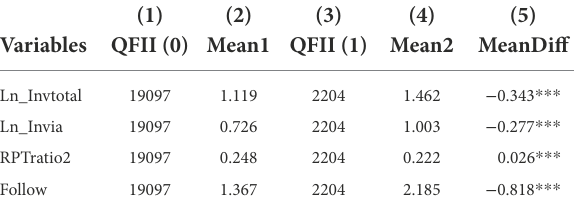
TABLE 2B Descriptive statistics grouped by